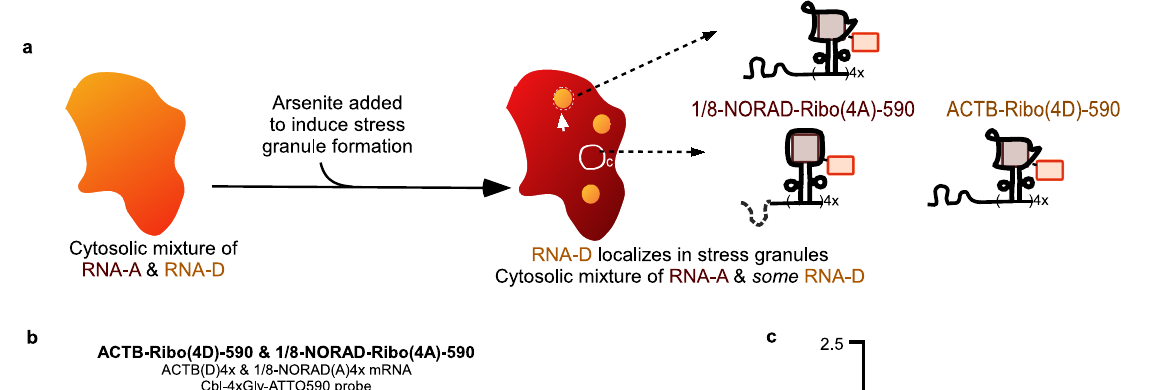
were identi fi ed (JF646-labeled SGs, yellow). Right: pixel-by-pixel component life- time image. Dashed line with white arrow: ROI of SG. Solid line labelled with ‘ C ’ : representativeROIofcytosol.Scalebar=10 μ m. c Average fl uorescencelifetime(as de fi ned inFig.2)value ofROIsrepresentingSGsand cytosol,de fi ned asanaverage value forthe entire ROI, asillustrated in b . Lifetime values for live cells (21 cells, 42 ROIs,2independentexperiments)listedinthebox-whiskerplotinwhichwhiskers= minimum and maximum values, black line= mean, box represents interquartile range (25th percentile to 75th percentile). Dotted lines represent the mean of the lifetime for benchmarks established from ACTB-tagged mRNA in Fig.